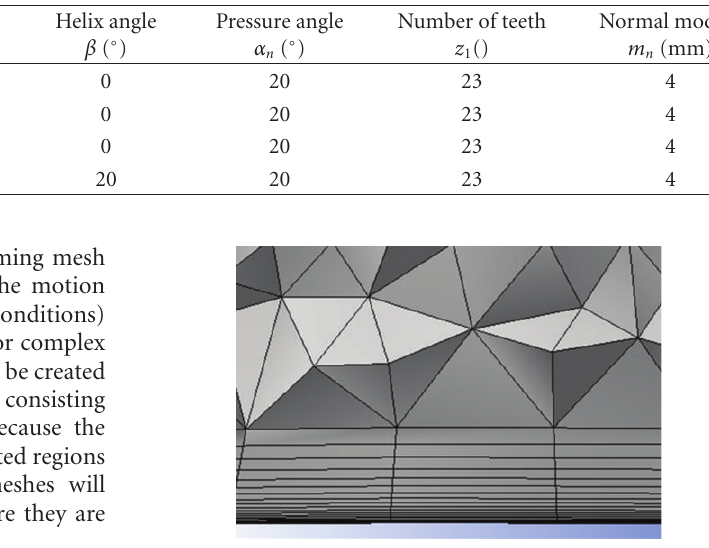
Table 3: Geometrical properties of the analyzed gears.